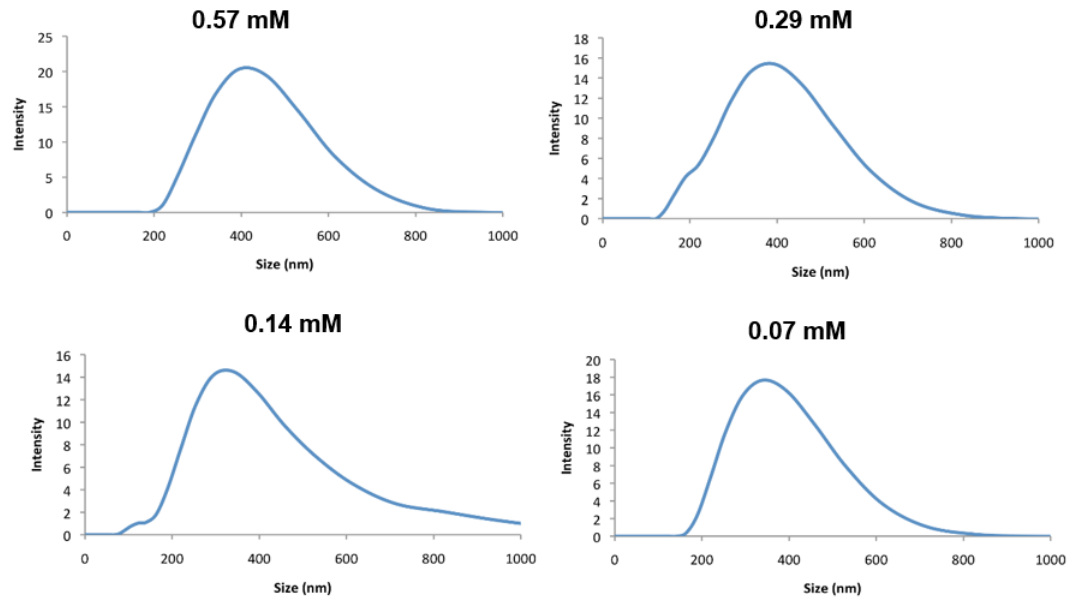
Figure 4. Plot of particle size distribution of complex 3 in water at indicated concentrations measured by DLS.